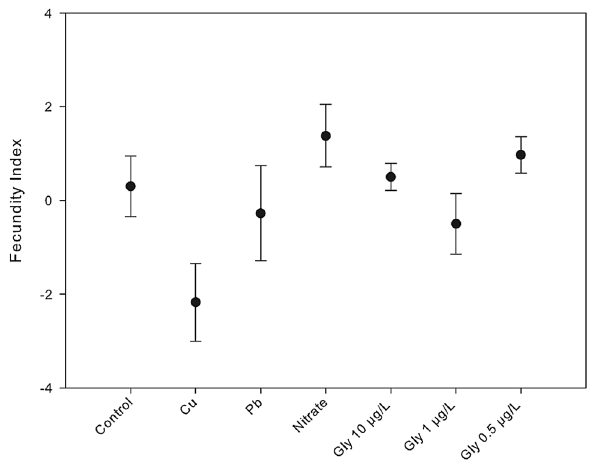
Figure 5. Mean variation of fecundity index of adult individuals of Carpodesmia crinita under control conditions and the different pollutant conditions treatments, 6 months after the beginning of the experiment. Vertical bars represent standard errors.